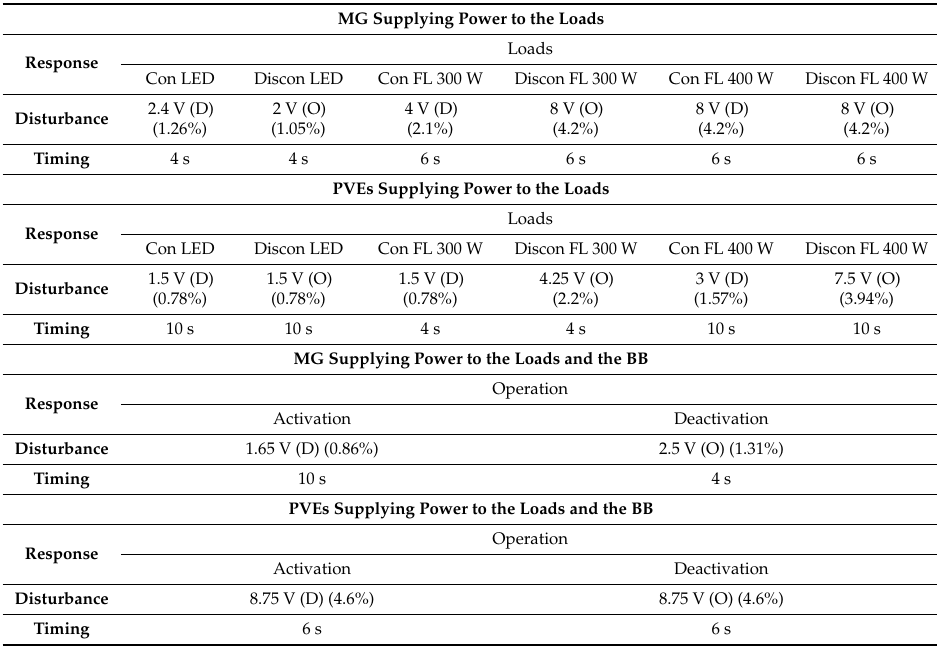
Table 8. Response of the DC-µG to the connection and disconnection of loads and sources.